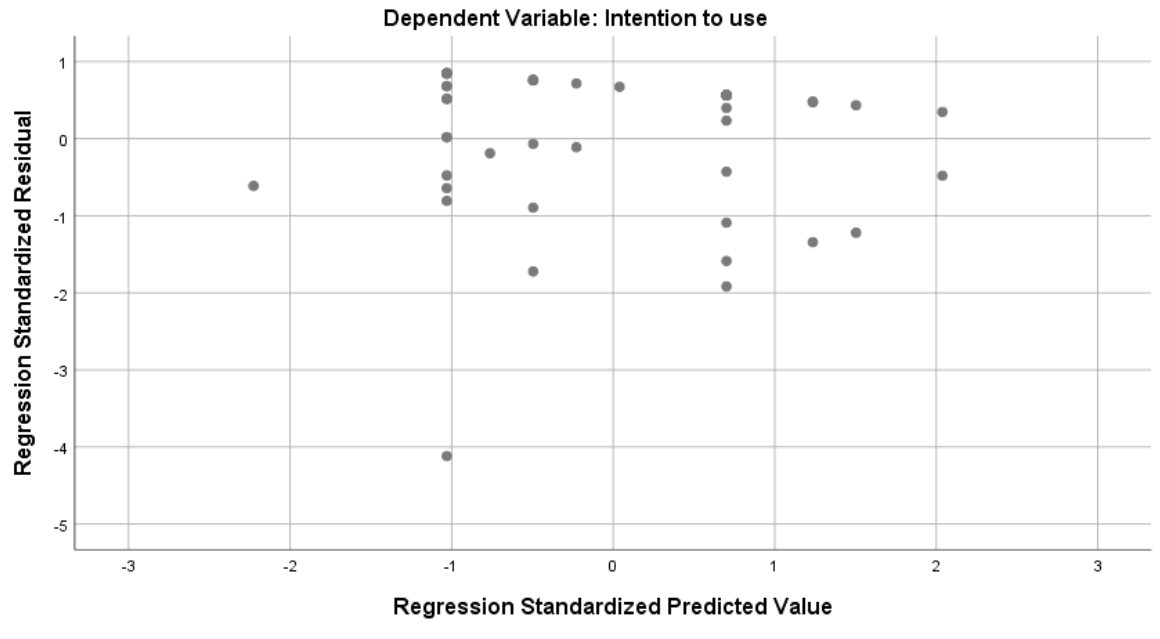
Figure 3. Standardized residuals.